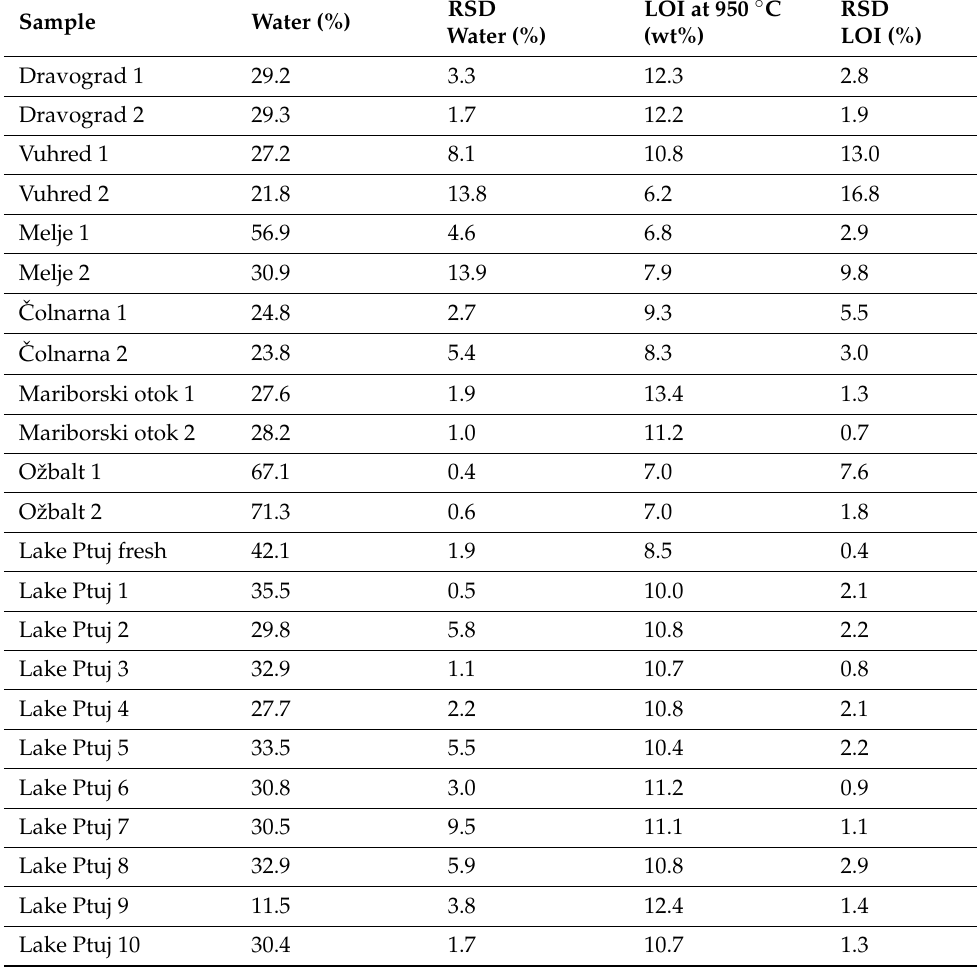
Table 1. Water 1 and LOI at 950 ◦ C 2 levels in the tested Drava River sediments. Sample Water